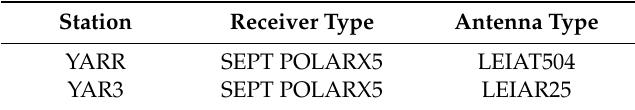
Table 4. Stations selected for the investigation of ISB characterization a ff ected by the antenna